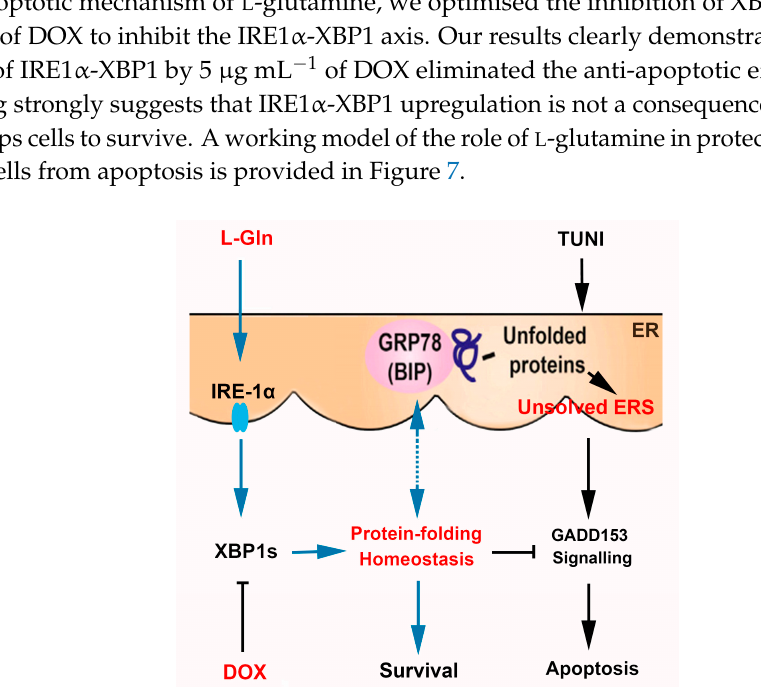
Figure 7. A working model of the role of L -glutamine in protecting an intestinal cell from apoptosis in response to prolonged ERS.